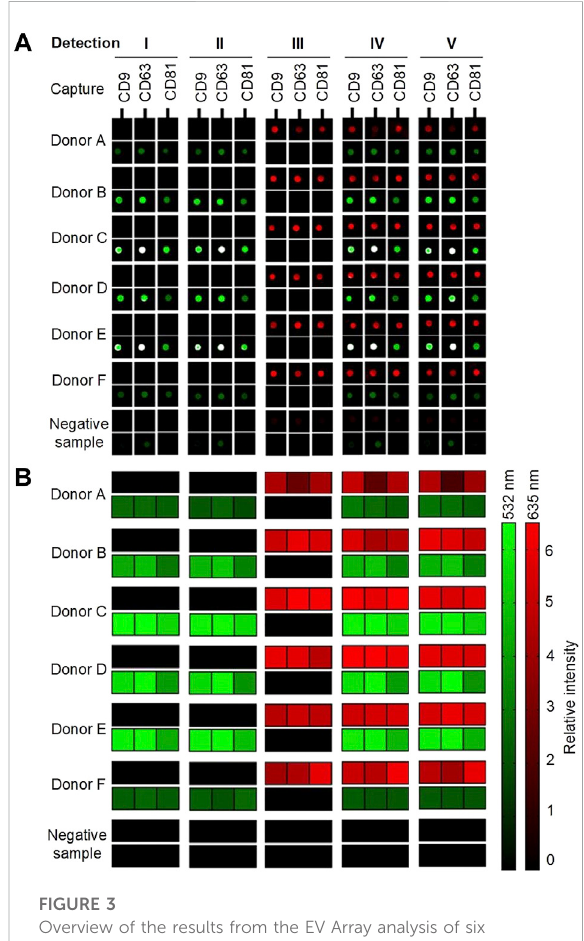
FIGURE 3 Overview of the results from the EV Array analysis of six donors (A – F) and a negative sample (incubation buffer). Five different compositions of detection antibodies were examined (Table 1; Figure 2). A cocktail with biotinylated murine anti- CD9, -CD63, and -CD81, rabbit anti- fl otillin-1, and/or anti-HSP90 were analyzed separately and simultaneously. (A) Spots indicate the capture of sEVs in a sample with printed antibodies: CD9, CD63, and CD81.Red signals (635 nm) originate from Cy5-labeled streptavidin reacting with the biotinylated murine antibodies. Green signals (532 nm) originate from Cy3-labeled goat anti- rabbit IgG bound to the fl otillin-1 and HSP90 rabbit antibodies. (B) Combined heatmap of the spot relative intensities (signal-to- background ratios). The red and green heatmaps summarize the intensities ofthebound